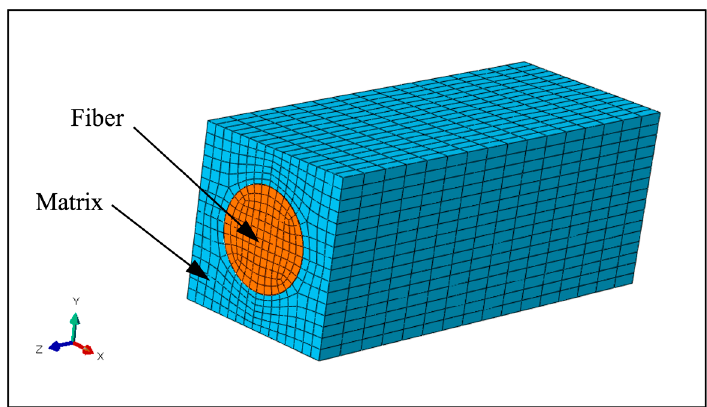
Figure 2. Three-dimensional finite element model of the unit-cell.